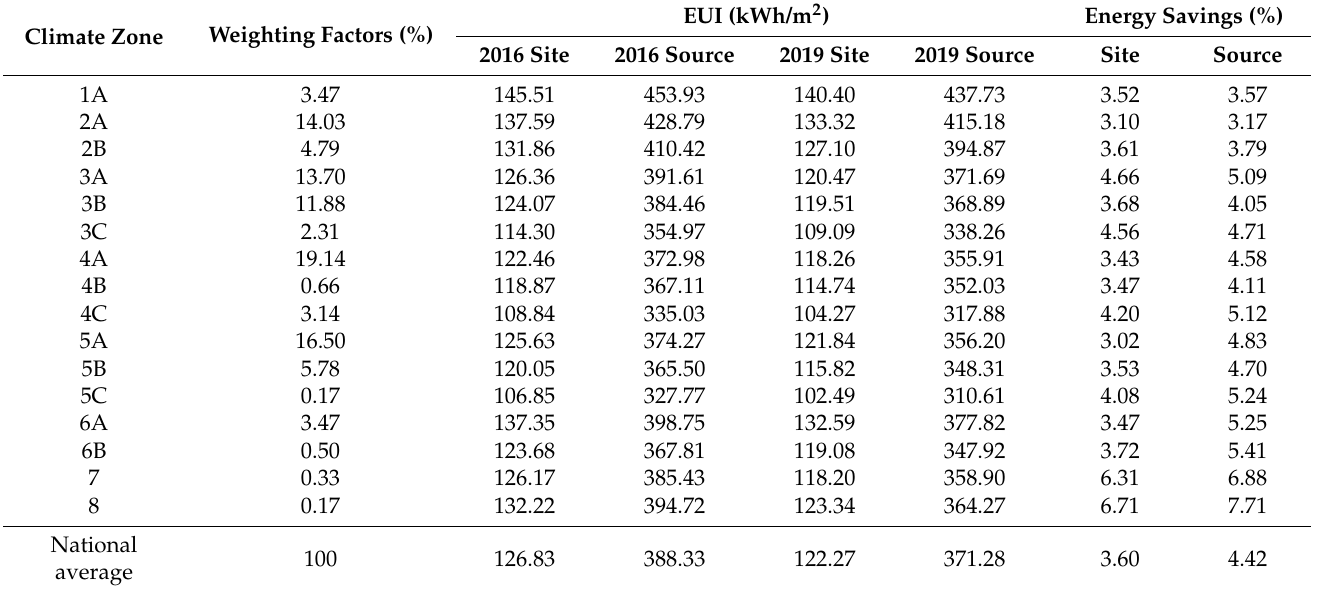
Table 9. The EUI and energy savings for the wasteful behavior